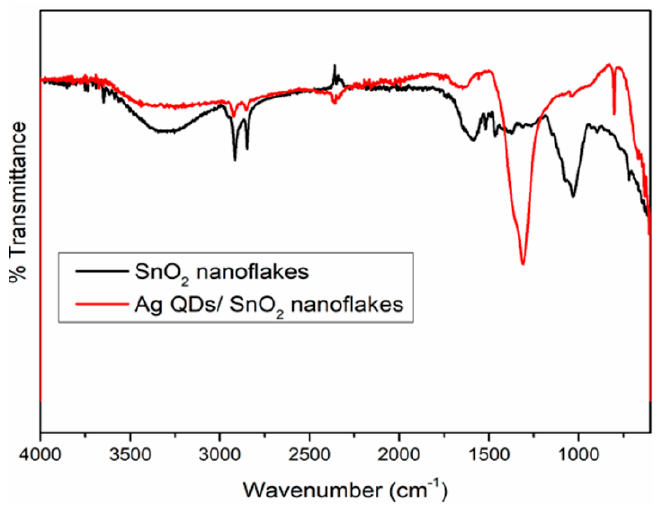
Figure 8. FTIR spectra of the SnO 2 and Ag QDs / SnO 2 nanostructures.